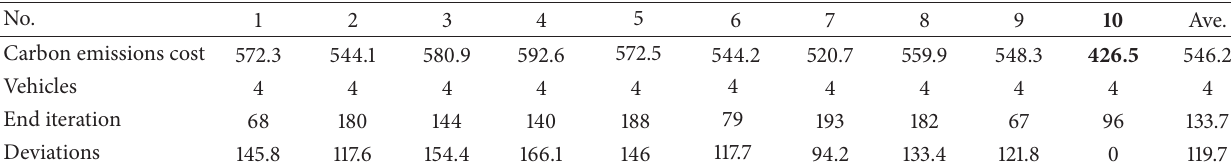
Table 3: The results of basic ant colony algorithm (minimum carbon emissions cost).